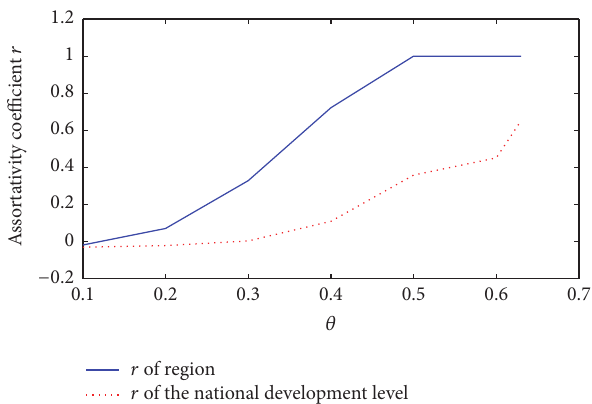
Figure 10: Assortativity coefficient, 𝑟 at different thresholds for the different classification criteria.